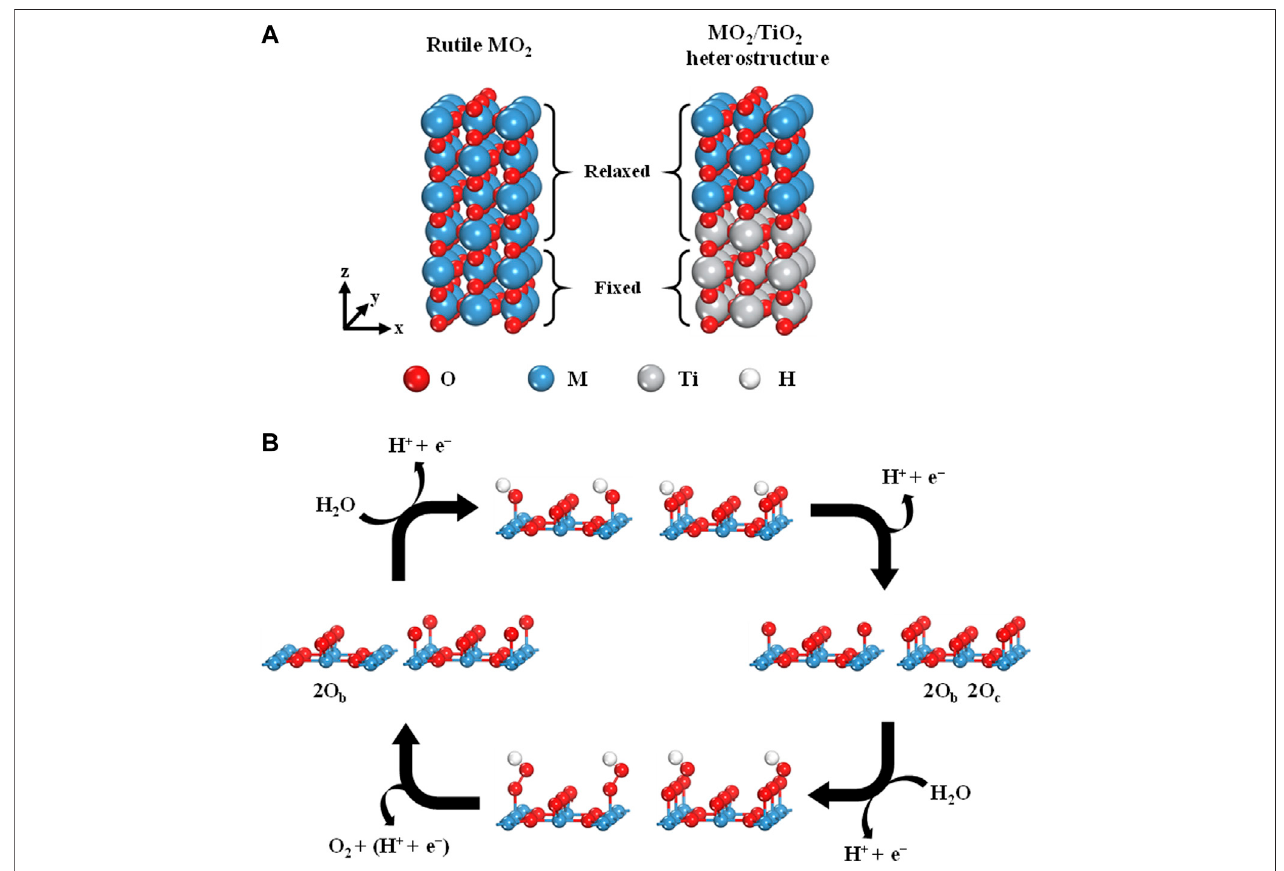
FIGURE 1 | (A) Six-layered (110) surface of rutile-type MO 2 (left) and MO 2 /TiO 2 heterostructure (right) . (B) OER scheme of four elementary reaction steps on the rutile-type (110) surface with 2O b and 2O b 2O c .